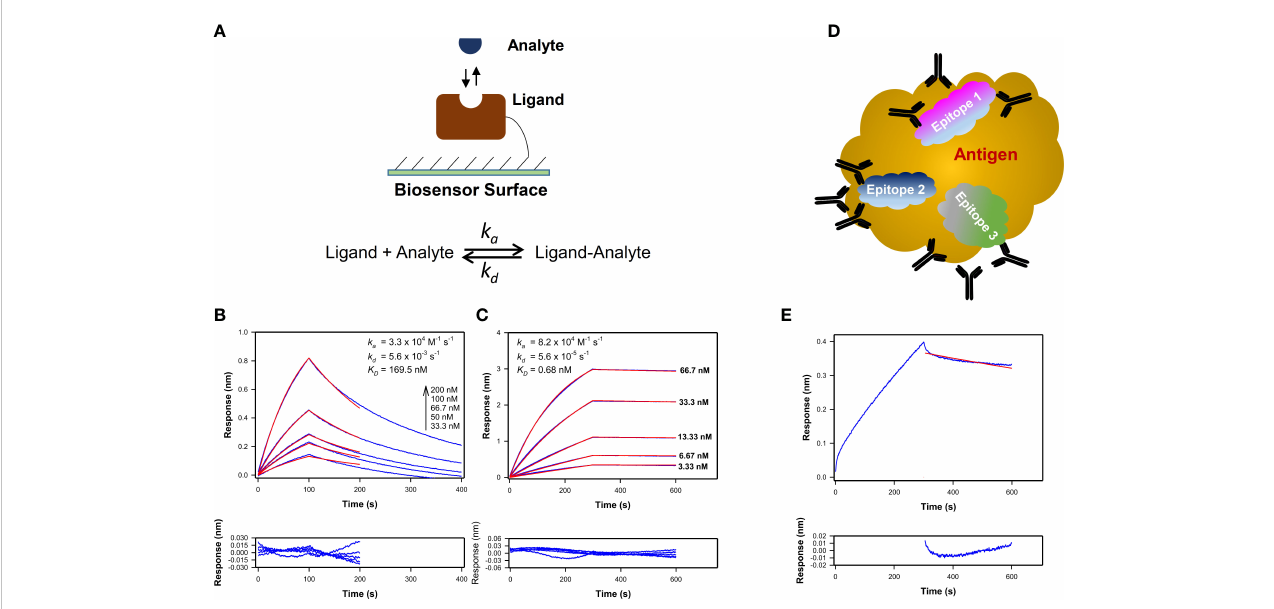
FIGURE 1 Kinetics pro fi les of monoclonal and polyclonal antibodies interaction with antigens. (A) Schematics showing the assay con fi guration for kinetics measurements of a homogenous analyte binding to a ligand immobilized on SPR or BLI biosensor to estimate the association and dissociation rate constants (k a and k d respectively) and K D value. (B, C) Time-courses of Plasmodium falciparum circumsporozoite protein central repeat region speci fi c mAb AB334 in its Fab form (B) and IgG1 form (C) binding (blue lines) at different indicated concentrations to a NANP repeat peptide NPNA3 with their best fi t to a 1:1 binding model overlaid (red lines) on them are shown. The residuals plots of the fi t are shown below the binding time-courses. The K D values estimated correspond to af fi nity in case of AB334 Fab binding (B) and avidity in case of AB334 IgG1 (C) respectively. (D) Schematic of a macromolecular antigen is shown as a gold colored cloud shape. The antigen presents multiple epitopes on its surface that are targeted by polyclonal antibodies. Three such epitopes are represented as cloud shapes in different colors (Epitopes 1-3). The observed macromolecular antigen binding time- courses arise from antibodies binding to different epitopes in parallel and some antibodies competing against each other for certain epitope(s). For simplicity, only monomeric antibodies are portrayed. (E) As an example of polyclonal antibodies binding, 1:50 diluted serum of a malaria vaccinee in a phase 2a trial (NCT01857869) binding to the NPNA3 peptide is shown (blue line) along with the 1:1 model fi t of the dissociation phase (red line). The residuals plot of the fi t is shown below the sensorgram